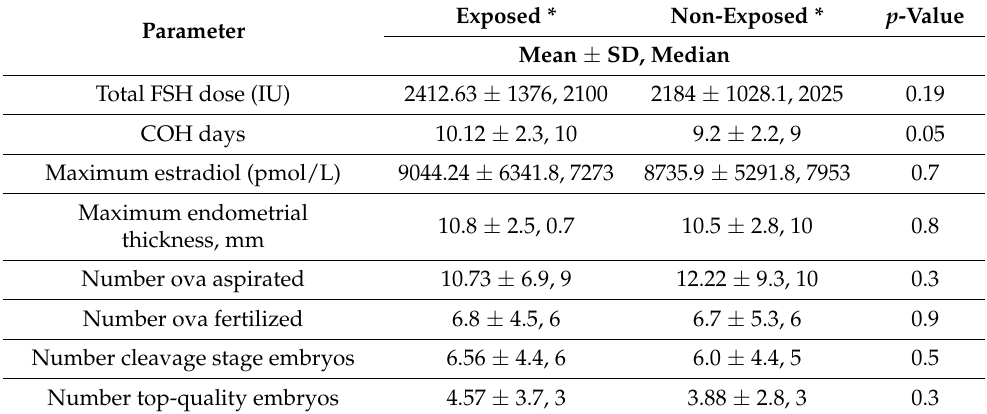
Table 1. Cycle outcomes for post-COVID-19 IVF treatment compared to non-exposed matched cycles. Exposed * Non-Exposed * p -Value Parameter Mean ± SD, Median Total FSH dose (IU) 2412.63 ± 1376, 2100 2184 ± 1028.1, 2025 0.19 COH days 10.12 ± 2.3, 10 9.2 ± 2.2, 9 0.05 Maximum estradiol (pmol/L) 9044.24 ± 6341.8, 7273 8735.9 ± 5291.8,